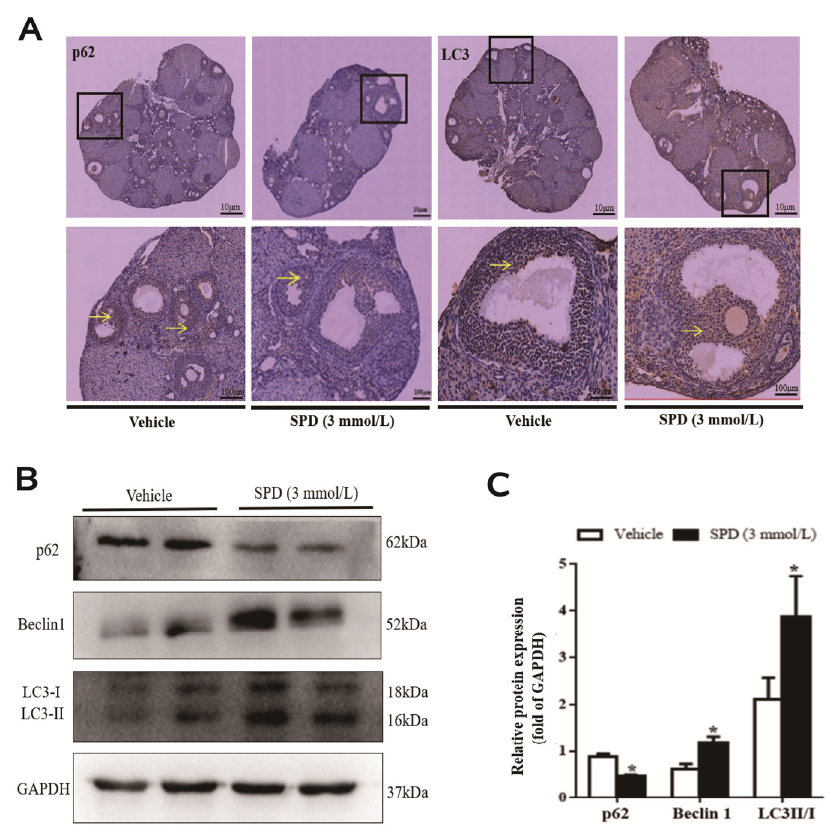
Figure 5. The effect of spermidine on the level of autophagy in mouse ovaries. ( A ) The effect of spermidine on the distribution of autophagy marker proteins determined by immunohistochemistry. Yellow arrow represents the distribution of autophagy-related antigen (cytoplasm). ( B ) Western blot visualization of the expression level of autophagy. ( C ) Quantitative expression levels of autophagy-related proteins. The results shown are representative of three independent experiments. * p < 0.05 vs. control.